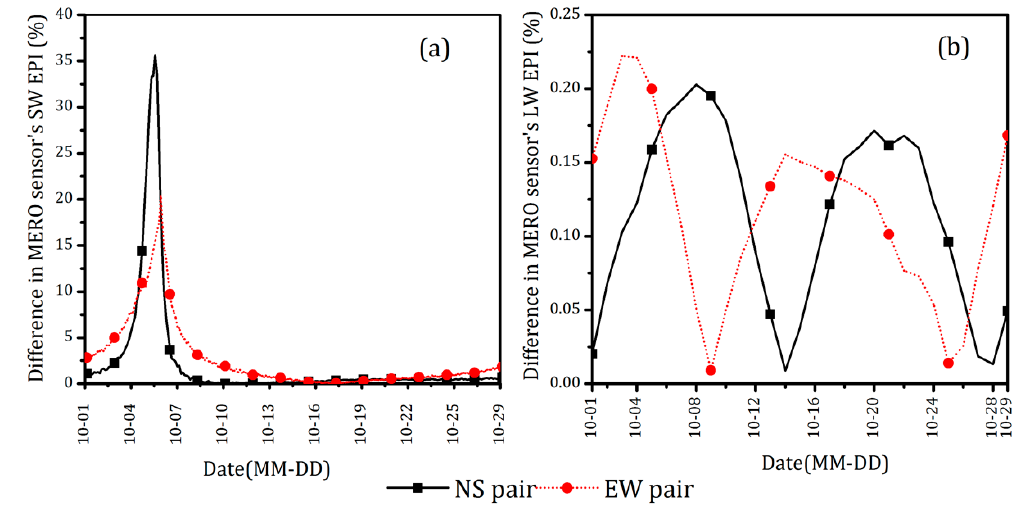
Figure 11. Time series of ( a ) differences in the MERO sensor’s SW entrance pupil irradiance (EPI) and ( b ) differences in the LW EPI, resulting from the hypothetical EW MERO location pair and from the NS MERO location pair over a Moon’s orbital period from October 1, 2017 to October 29, 2017.